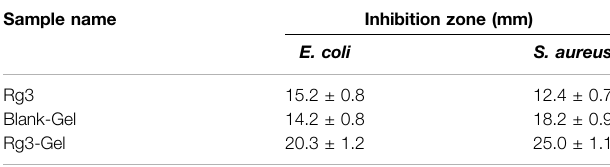
TABLE 1 | Bacterial inhibition zone of the different samples. Sample